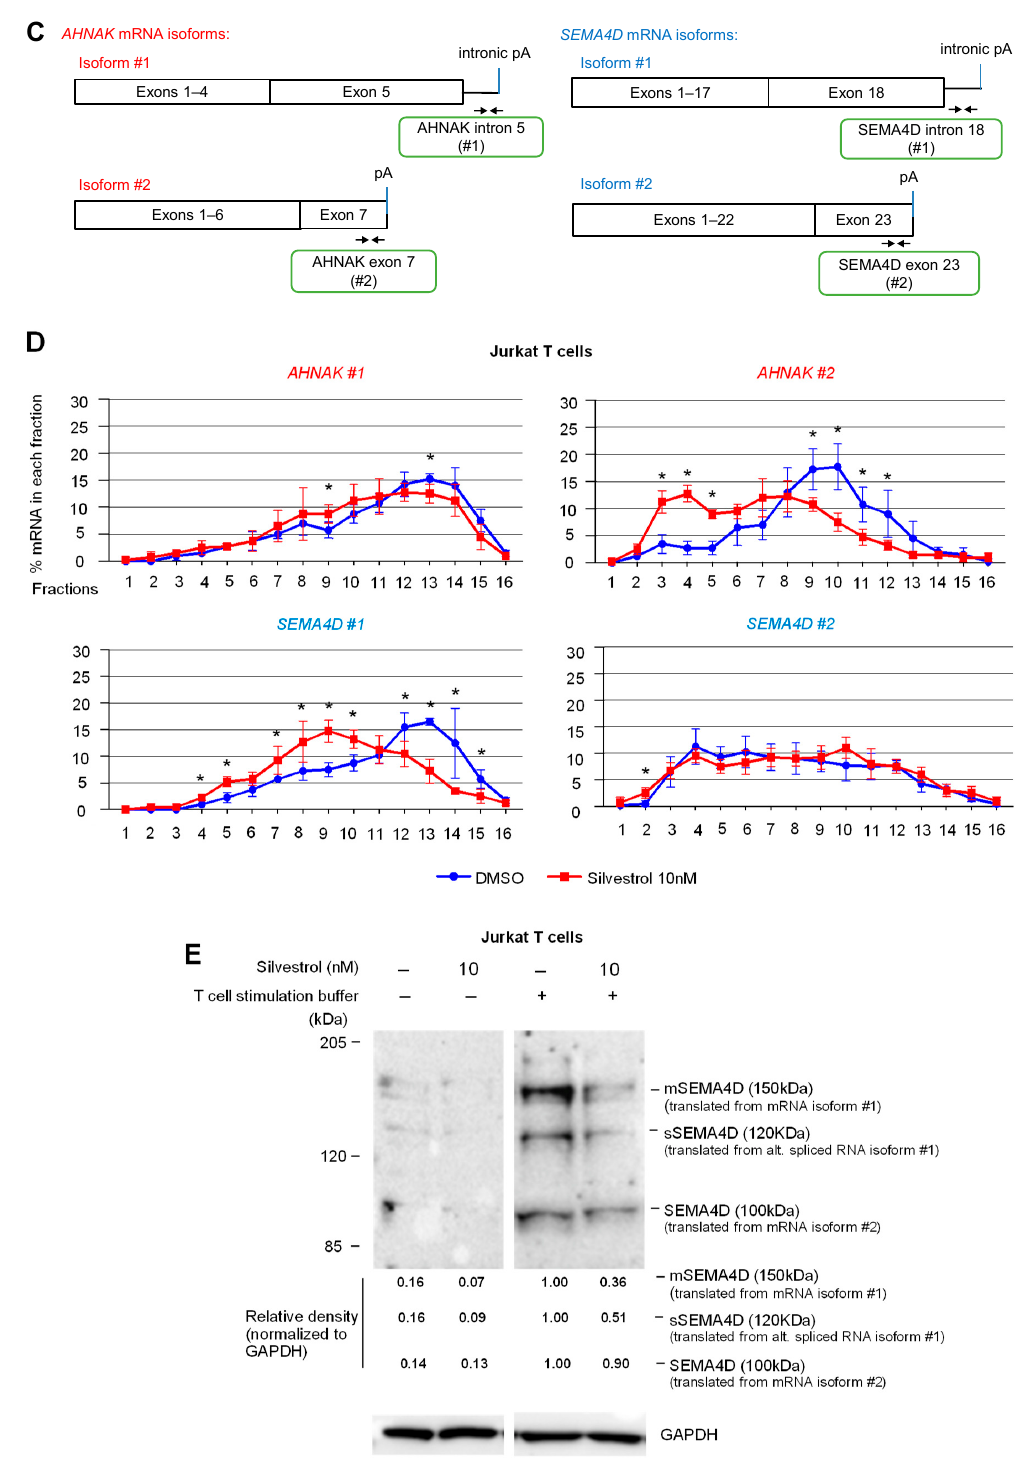
Figure 4 Figure 4. eIF4A inhibition regulates the translation of several immune-related alternatively polyadenylated mRNAs. ( A ) Regulation of intronic polyA (IPA) versus last exon (LE) isoforms in heavy polysome fractions following treatment with silvestrol (10 nM) for 2 h in CD8+ T cells from healthy donors. IPA sites that are significantly upregulated (IPA:LE up) or downregulated (IPA:LE down) by silvestrol relative to LE ( p -adj < 0.1) are shown in red and blue, respectively; ( B )‘number of genes with either up- or downregulation of IPA:LE isoform ratio by silvestrol in heavy polysome fractions or whole cytosol, as indicated; ( C ) primer design for candidate immune-related gene